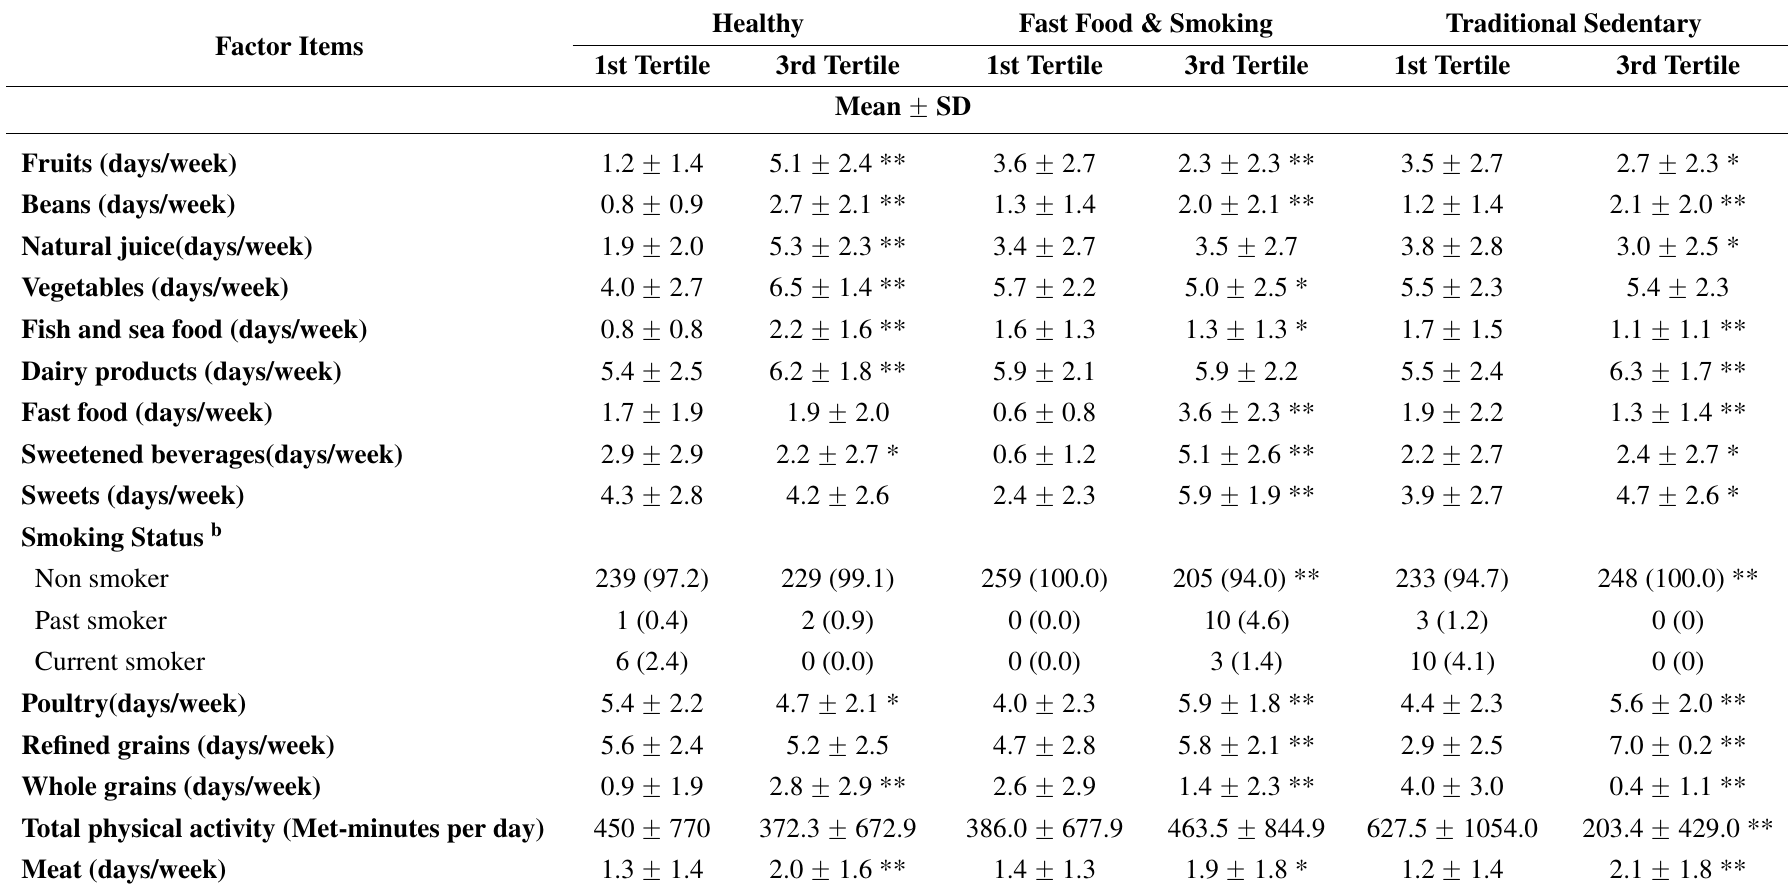
Table 3. Weighted dietary intake, smoking, and physical activity of study participants by tertiles of the three identified patterns’ scores a ( n =